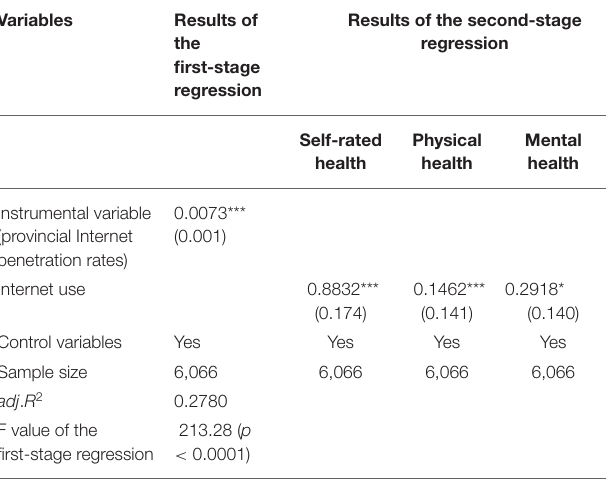
TABLE 3 | The treatment of endogeneity: instrumental variable model.